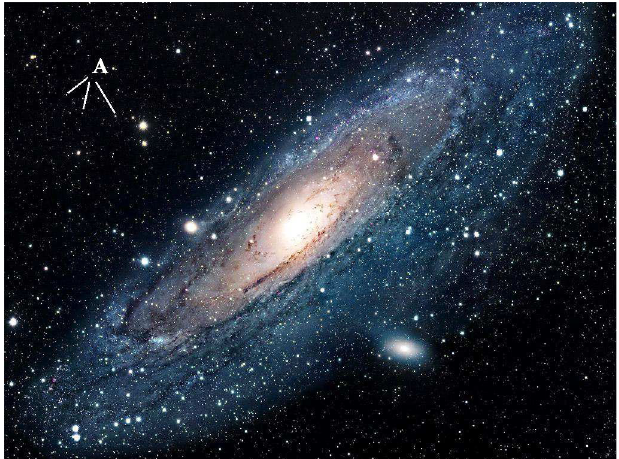
FIG. 2. The Andromeda Galaxy. Following open-ended ques- tions were asked: This is the photograph of the Andromeda galaxy. What do you think the thousands of tiny dots (such as A) are in this photo?; They belong to ___ a. Our Galaxy, b. The Andromeda galaxy, c. The empty space between our Galaxy and the Andromeda galaxy, d. None of the above; and, Why did you choose your answer in the above